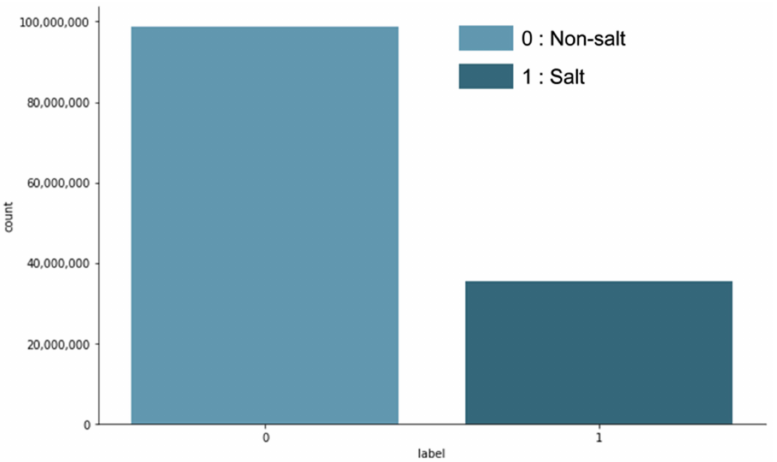
Figure 13. The labels’ distribution.